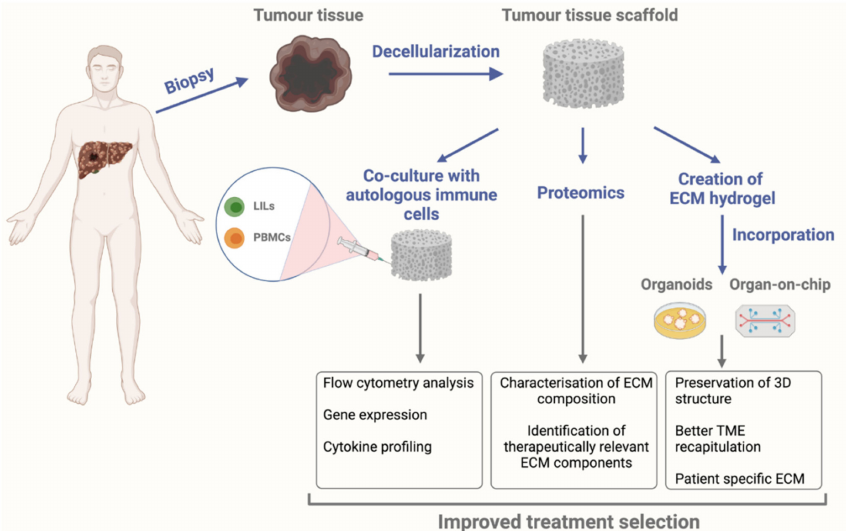
Figure 2. An example of a personalised bioengineered model that could be used to determine the best course of treatment for patients. In this model, we envisage that a tissue sample from the tumour site can be obtained using biopsy after which acellular scaffolds can be generated using decellularization. These tissue scaffolds can then have various applications including co-culture with autologous immune cells, analysis of composition with proteomics, or can be a source material for ECM hydrogels used in 3D disease models. LILs: liver infiltrating lymphocytes, PBMCs: peripheral blood mononuclear cells. The figure was created using BioRender (https://app.biorender.com, accessed 4 November